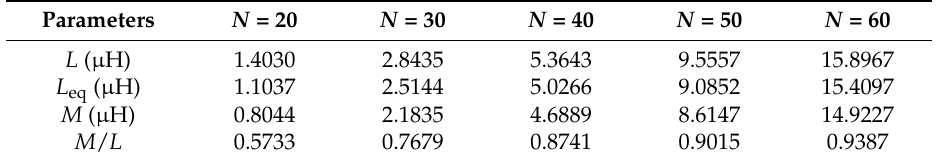
9 of 15 the blue line was 2.0 MHz; ( b ) detection results of copper particles with sizes ranging from 140 to 150 μ m,